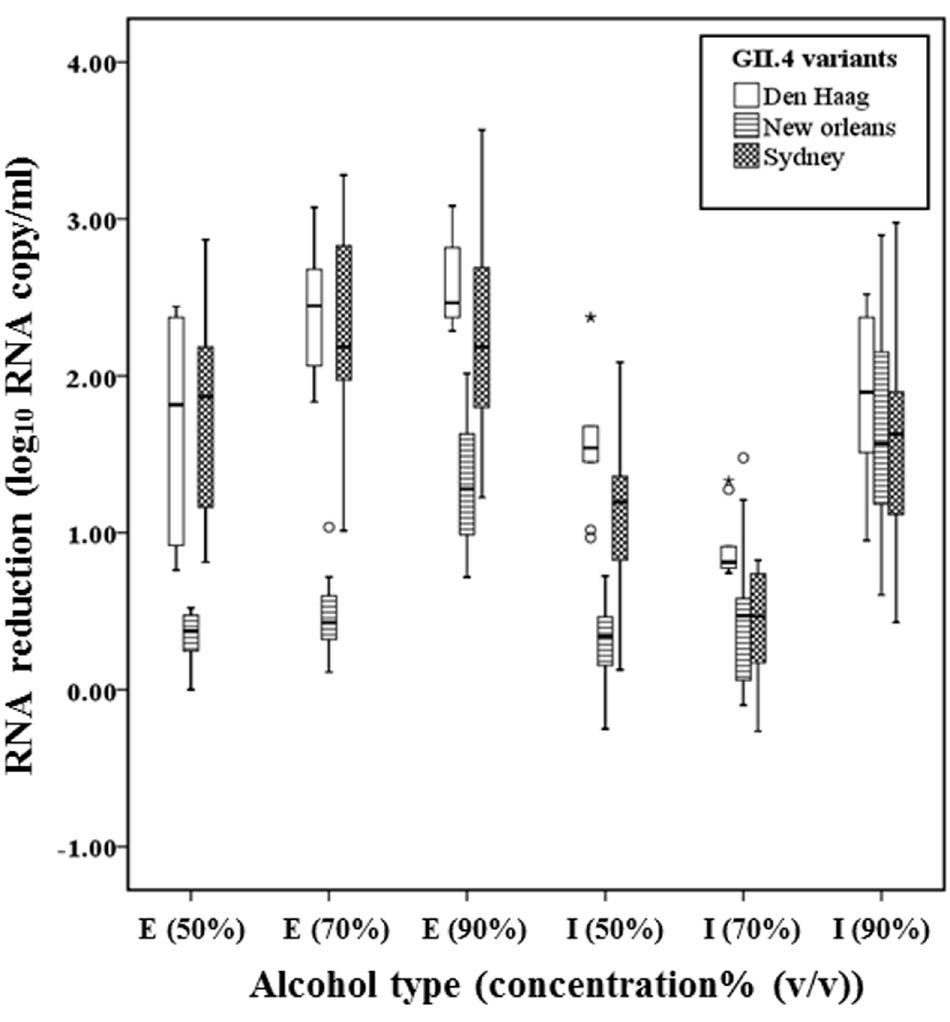
Fig 2. Virolysis patterns of GII.4 variants including GII.4 Den Haag, GII.4 New Orleans and GII.4 Sydney viruses after exposure to ethanol (E) and isopropyl alcohol (I) at 3 different concentrations (50%, 70%, and 90%). 2 GII.4 Den Haag, 3 GII.4 New Orleans and 4 GII.4 Sydney strains with three replicates were consolidated by genotype and were expressed as a box plot. The upper, lower ends of the box and the horizontal line in the box indicate the first (Q1), third quantiles (Q3) and median value of all data, respectively. The lower and higher ends of whiskers indicate the minimum and maximum value of all data, respectively. Isolated points are